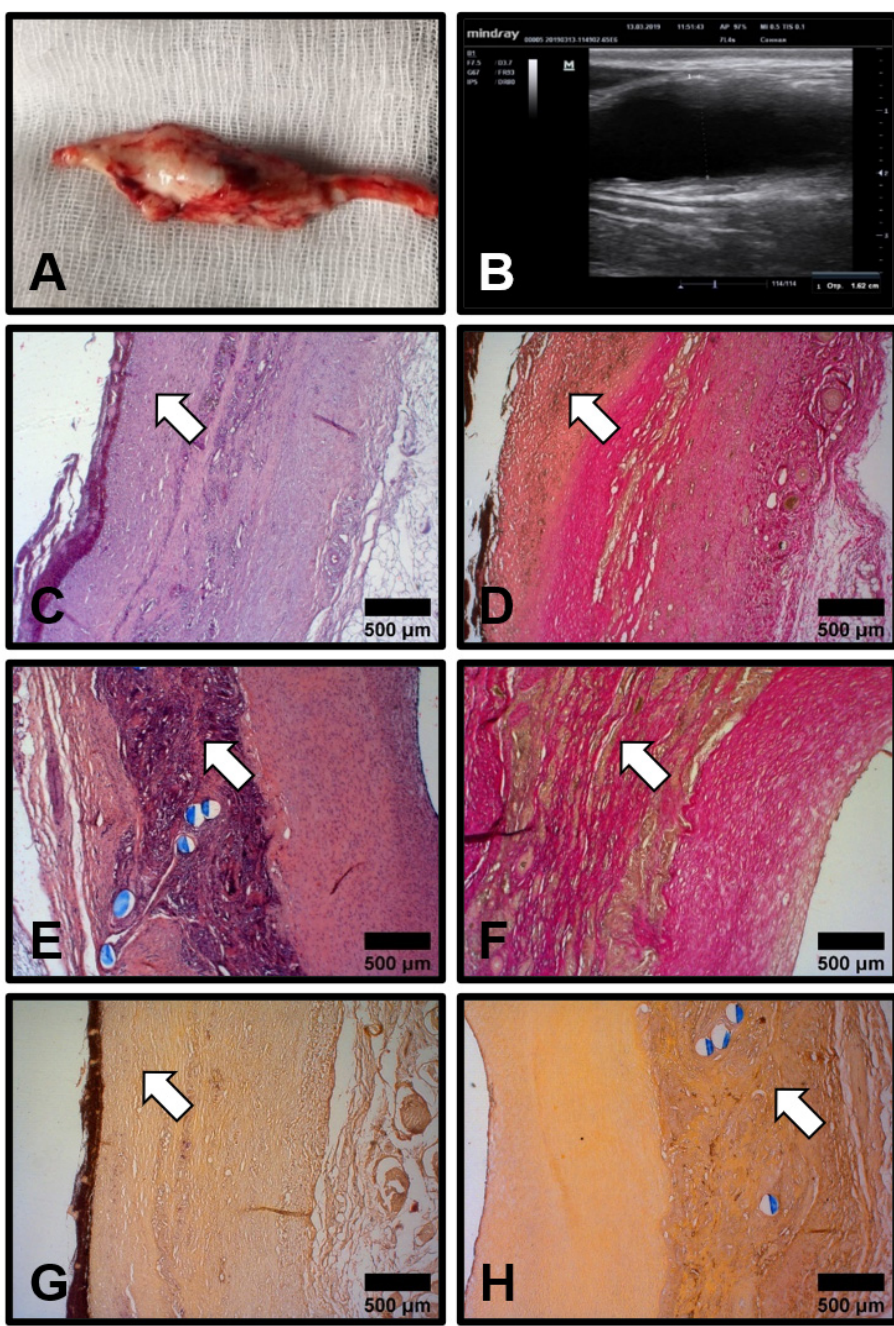
Figure 3. Development of the aneurysms in the patent PHBV/PCL[VEGF-bFGF-SDF] Hep/Ilo grafts 6 months postimplantation. ( A ) Gross examination of the aneurysm which developed through the whole length of the graft; ( B ) Ultrasound examination of the same aneurysm; ( C , D ) Neointima (indicated by white arrows) demarcated from the degrading polymer scaffold by an organised layer of collagen fibres. Haematoxylin and eosin staining ( C ) and van Gieson staining ( D ), ×50 magnification; ( Е , F ) Degrading polymer scaffold is partially substituted by collagen bundles (white arrows) formed de novo. Haematoxylin and eosin staining ( E ) and van Gieson staining ( F ), ×50 magnification; ( G , H ) Absence of calcium deposits both within the neointima ( G , white arrow) and polymer scaffold ( H , white arrow). Alizarin red S staining, ×50 magnification. Representative images.